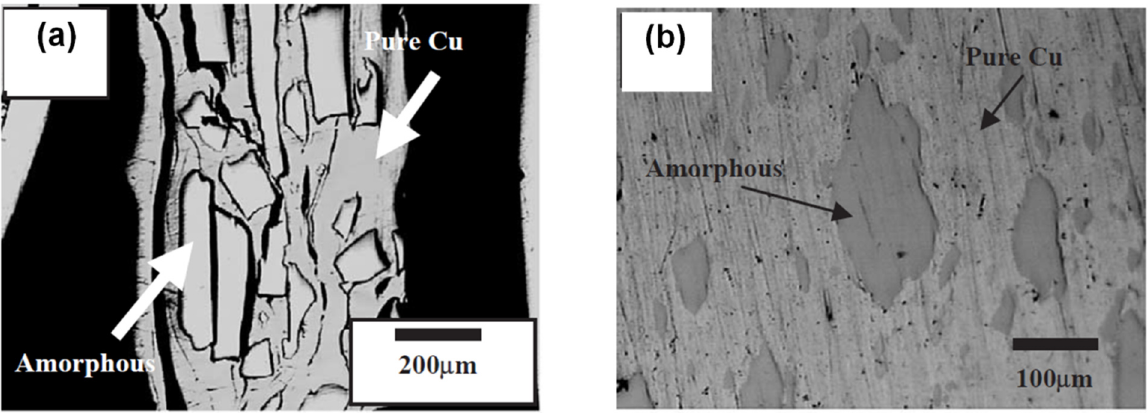
Figure 4. Microstructure of Cu + Ni-Zr-Ti-Si-Sn metallic glass composites obtained via ( a ) cold rolling and folding of Cu foils with Ni-Zr-Ti-Si-Sn metallic glass ribbons, ( b ) warm rolling of cold-rolled composites sealed in a Cu tube. Reprinted from [36], Copyright (2004), with permission from